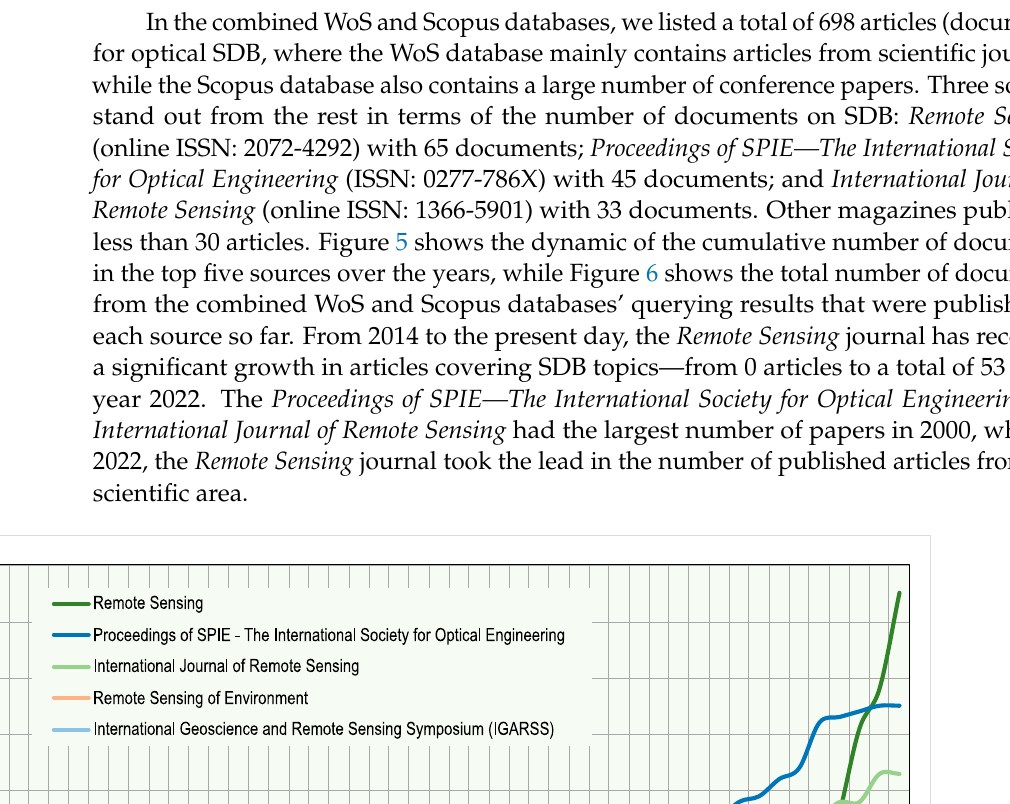
Figure 6. Fifteen most relevant sources from the unified WoS and Scopus databases. Figure 7 shows the number of local citations across sources, i.e., journals. Local cita- tions are extracted from the reference lists of all 698 documents included in the unified WoS and Scopus database. They represent the number of documents that were cited in all 698 documents included in the analysis and are summed by sources. The top five sources by local citations are the following: Remote Sensing of Environment (online ISSN: 1879-0704) with 452 local citations is the first one, followed by Applied Optics (online ISSN: 2155-3165) with 428, International Journal of Remote Sensing (online ISSN: 1366-5901) with 266, Limnol- ogy and Oceanography (online ISSN: 1939-5590) with 237 and Remote Sensing (online ISSN: 2072-4292) with 229 local citations (Figure 7). Table 3 shows 16 journals according to the WoS database with the largest number of published papers in the field of “optical SDB”, the citations of published papers and the ratio of published and cited papers. Most papers on the subject of SDB were published in the journal Remote Sensing (Basel) (ISSN: 2072-4292), with a total of 56, while the papers published in the journal Remote Sensing of Environment (ISSN: 344257) were the most cited, with a total of 1360 citations. Applied Optics (ISSN: 1559-128X) has the highest ratio of cited and published works with 106.73, while the lowest ratio is 1.50 with respect to the Journal of the Indian Society of Remote Sensing (ISSN: 0255660X). The table also shows differ- ent journal ranking indexes (h-index, Journal Impact Factor, Cite Score, and SJR) and the best quartile for each journal. The journal Remote Sensing (Basel) (ISSN: 2072-4292) has the